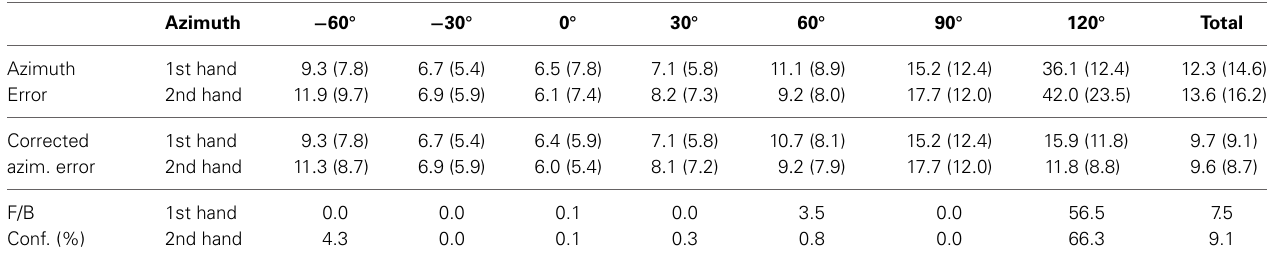
Table 1 | Mean of absolute azimuth and corrected azimuth error in degree (standard deviations in parenthesis) and front/back confusion rate as a function of stimuli